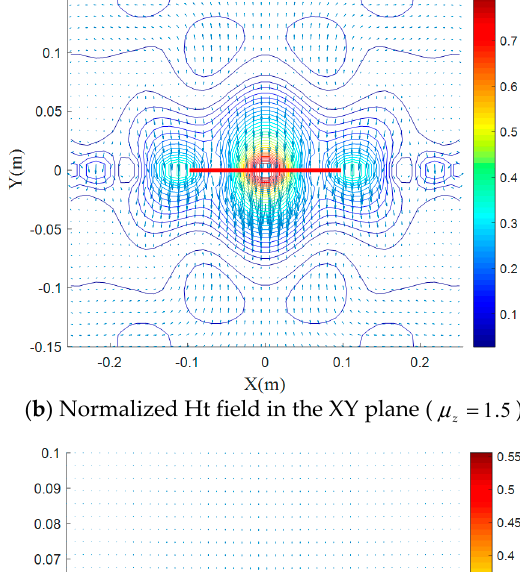
μ with 253 . == εε and 1 = μ , in the XY, t tz z